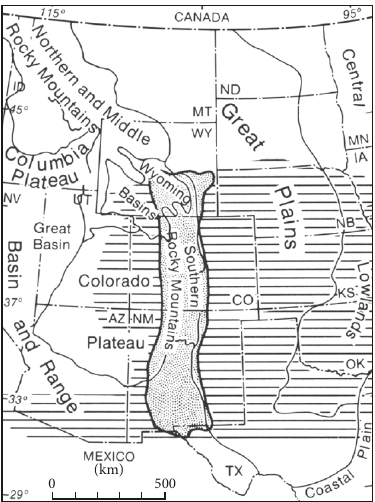
Figure 3: Index map showing key elements of the Eaton Alvarado ridge in relation to political boundaries (dash-dot lines) and phys- iographic province boundaries (thin solid lines); some of the latter provinces are grouped together and labelled. The region around the crest of the Alvarado ridge is outlined by a heavy solid line (Figure 2 of